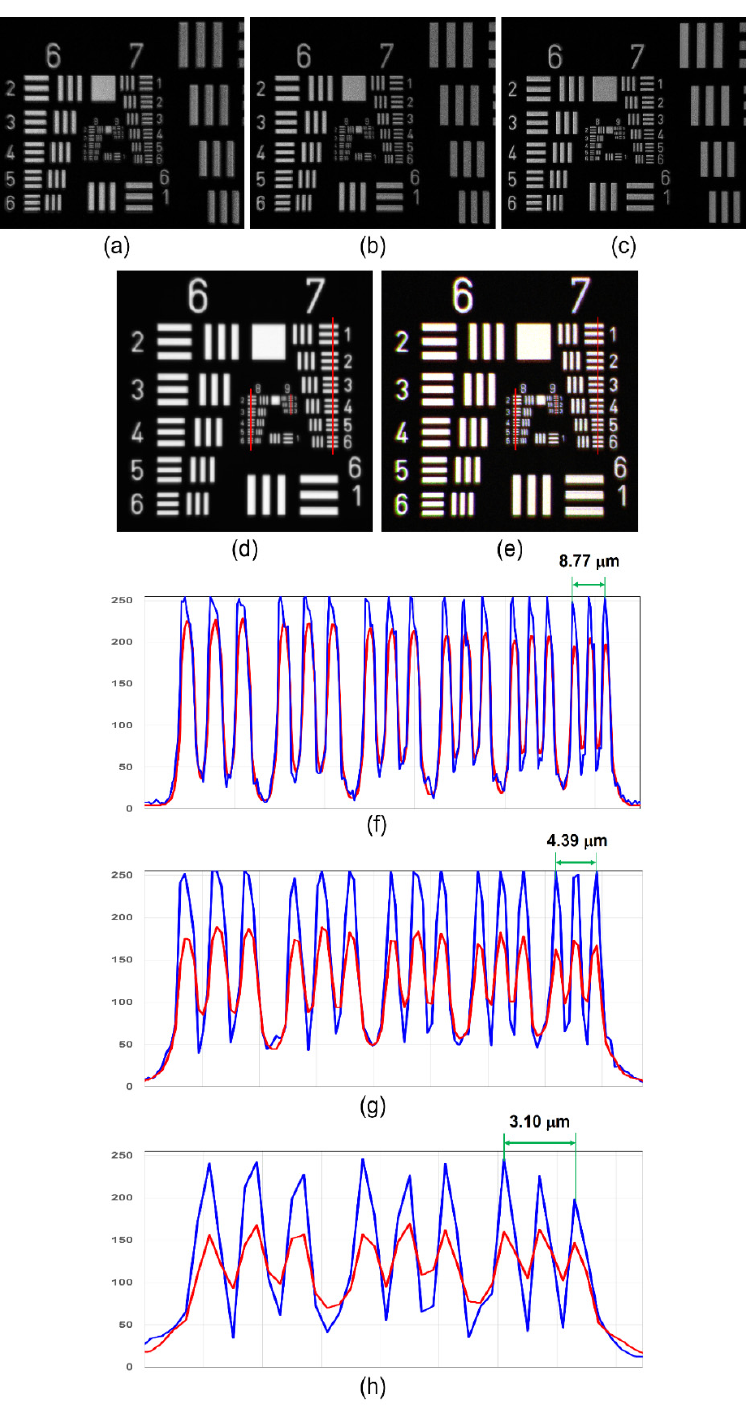
Figure 27. Experimental results. Reconstructed images at wavelengths of ( a ) 618, ( b ) 530, and ( c ) 455 nm. ( d ) Photograph of the specimen and ( e ) color-synthesized image generated from ( a – c ). Plots of borderlines in ( d , e ) along groups ( f ) 7, ( g ) 8, and ( h ) 9. Red lines in ( d , e ) indicate the locations where the plots are selected. In ( e ), the white balance was calculated during synthesis. Red and blue lines in ( f – h ) indicate the results obtained from ( d , e ), respectively.